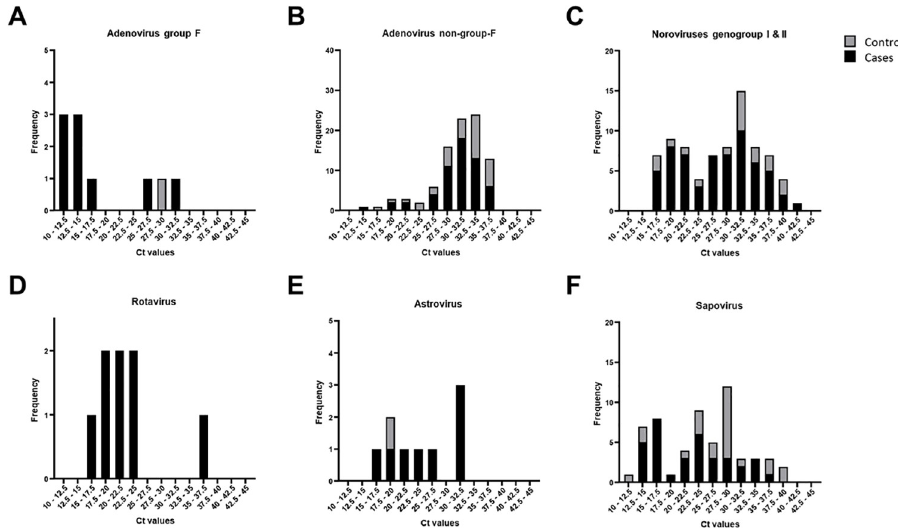
Fig 2. Distribution and frequency of PCR positive samples for astrovirus, Adenovirus non-group-F, adenovirus group F, sapovirus, rotavirus, and noroviruses (genogroup I & genogroup II). Shown are the results for adenovirus- F (A), adenovirus-non-F (B), noroviruses (C), rotavirus (D), astroviru (E) and sapovirus (F). Shown is the number of positive materials from cases (black bars) and controls (grey bars) per category of Ct values (bin size 2.5 Ct).